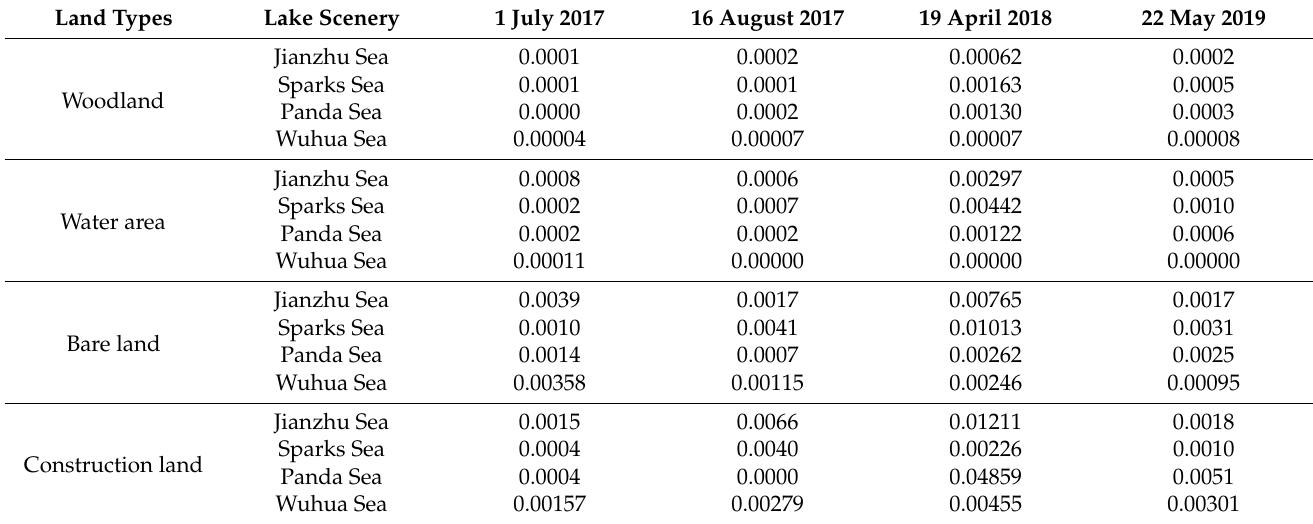
Table 7. Comparison of fragmentation indexes in different periods before and after earthquakes (km 2